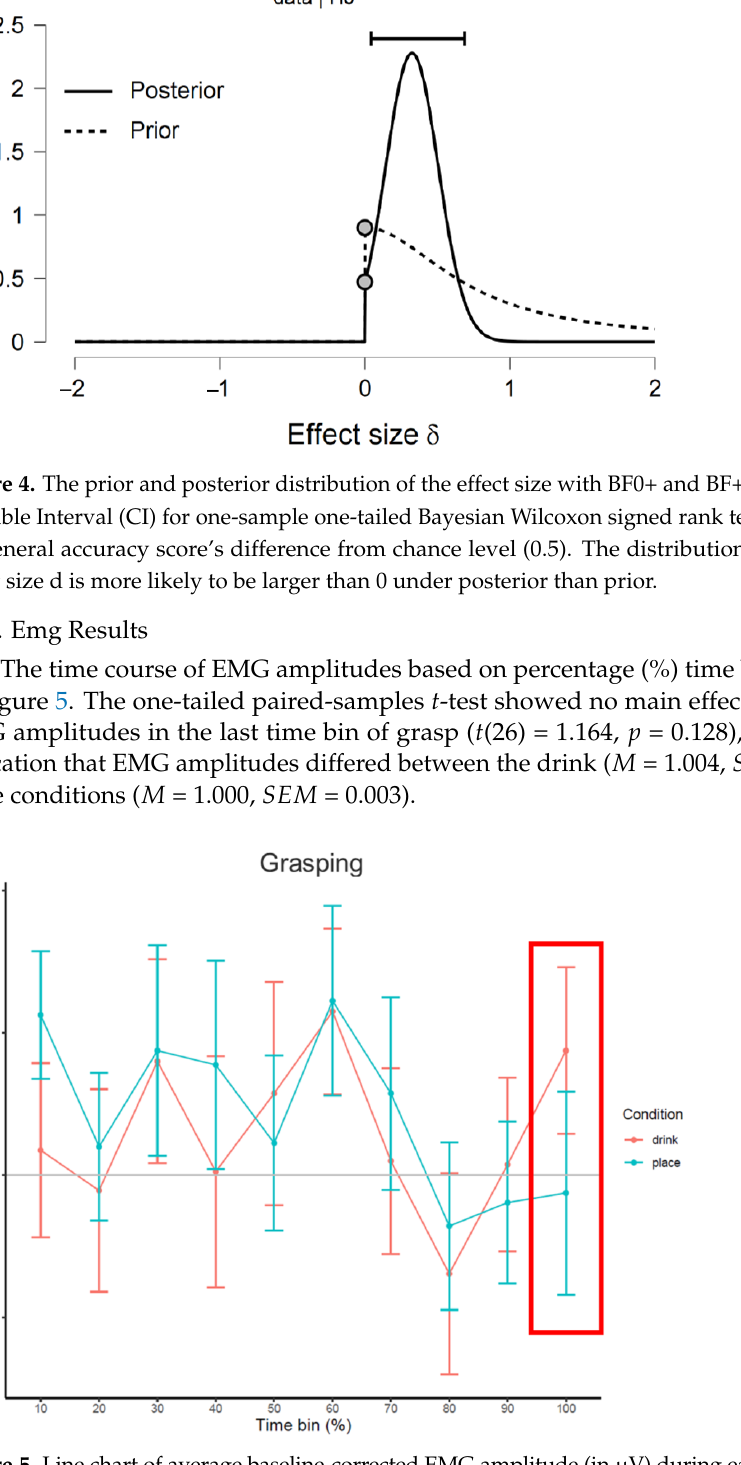
Figure 5. Line chart of average baseline-corrected EMG amplitude (in µ V) during each percentage time bin of the grasping part for drink and place conditions, with standard error bars ( ± 1 SEM ) and a grey line at baseline level (y = 1). Time bin used for statistical analysis is highlighted in the red